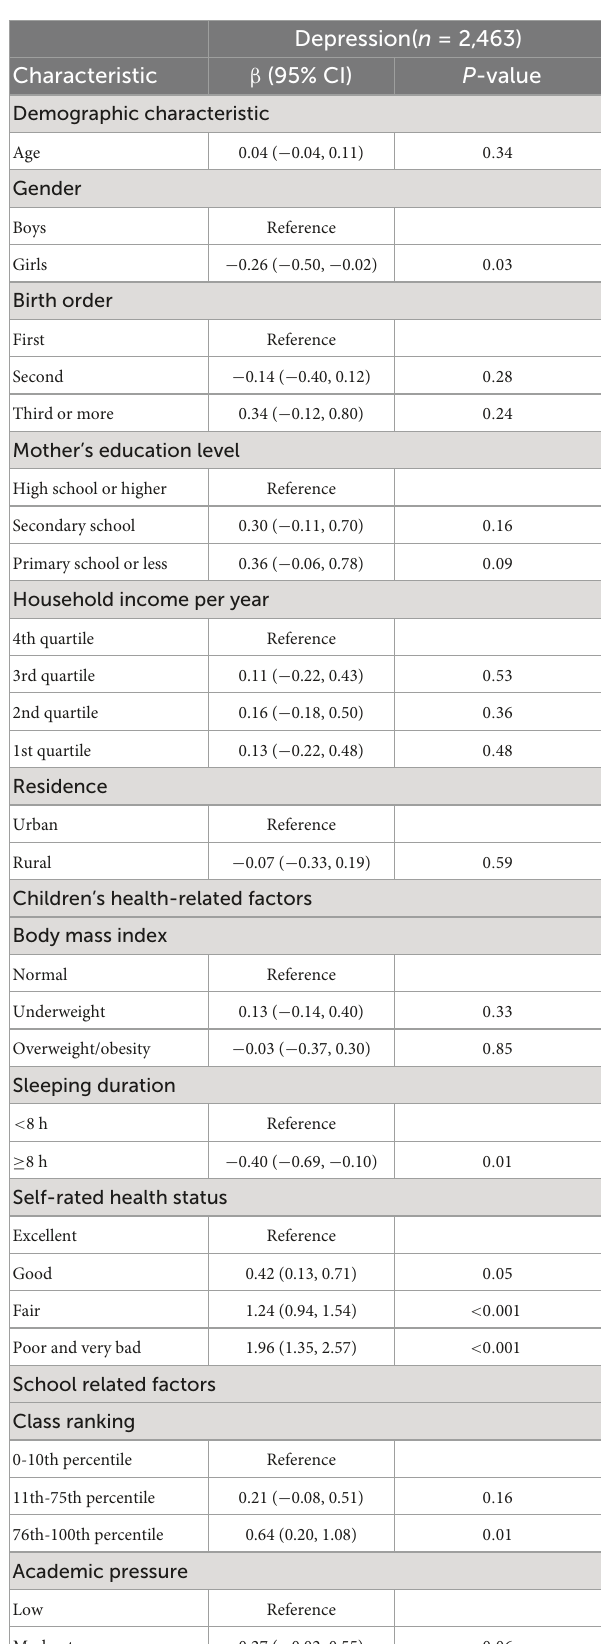
TABLE 3 Multivariable linear regression analysis of the associated factors with depression in the imputed dataset ( n =